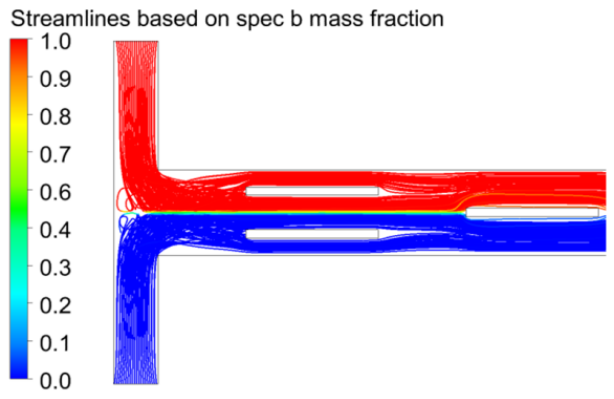
Figure 11. Streamlines of T-mixer with TDOs from top view at Re = 133